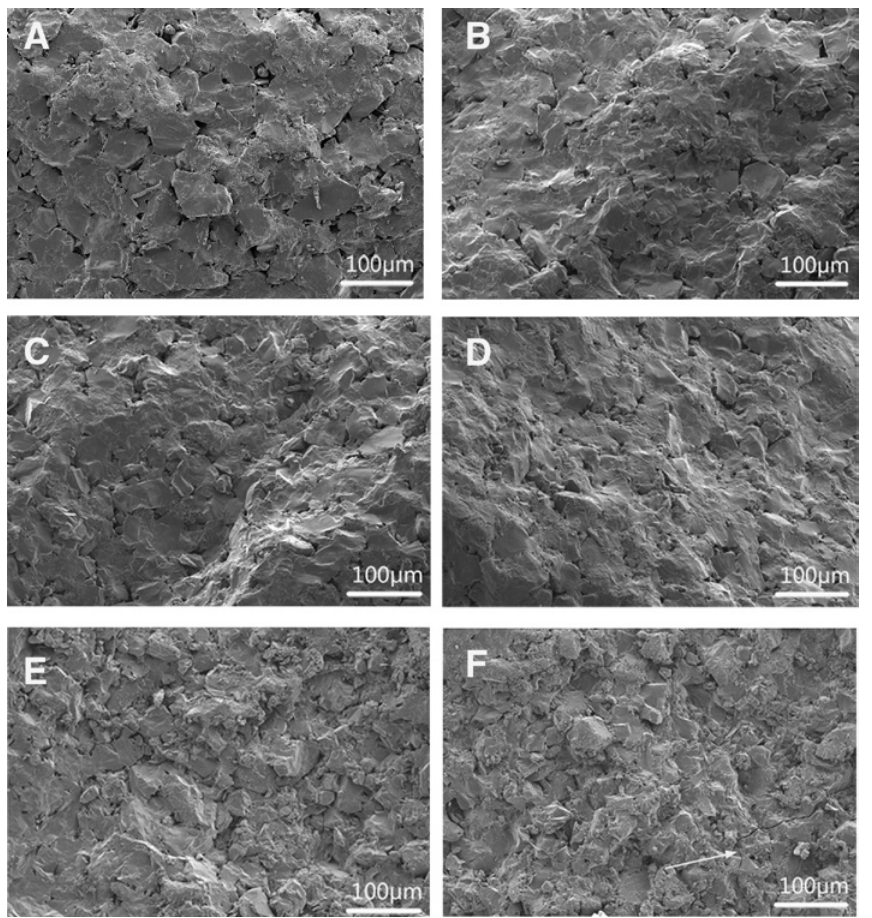
Figure 5: The microscopic observation of porosity evolution: (A) stress of 0.00 MPa; (B) stress of 4.00 MPa; (C) stress of 4.50 MPa; (D) stress of 5.00 MPa; (E) stress of 5.25 MPa; (F) stress of 5.50